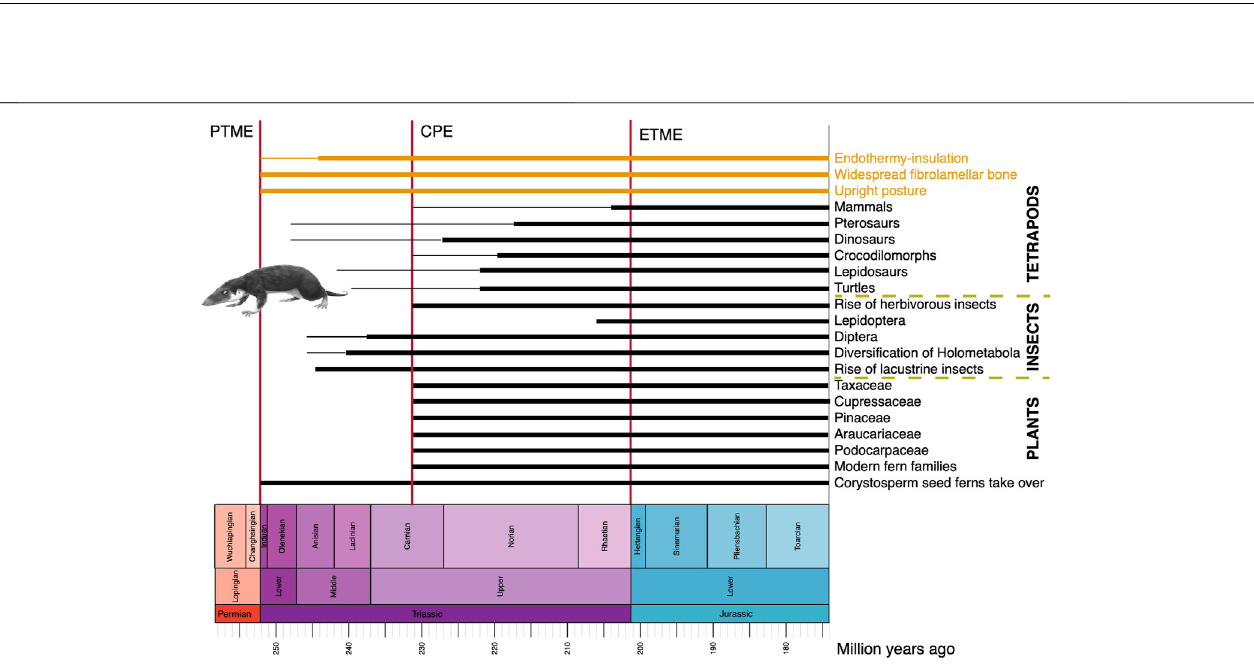
FIGURE 9 | Novel physiological and functional characteristics, new tetrapod, insect and plant groups in the Triassic on land. As in Figure 2 , the image shows approximate timings of known fossil records, or times when a phenomenon became established (thick line) and earlier occurrences, either inferred from phylogeny or based on rare fossils (thin line). The early mammal Morganucodon is by FunkMunk (Wikimedia).